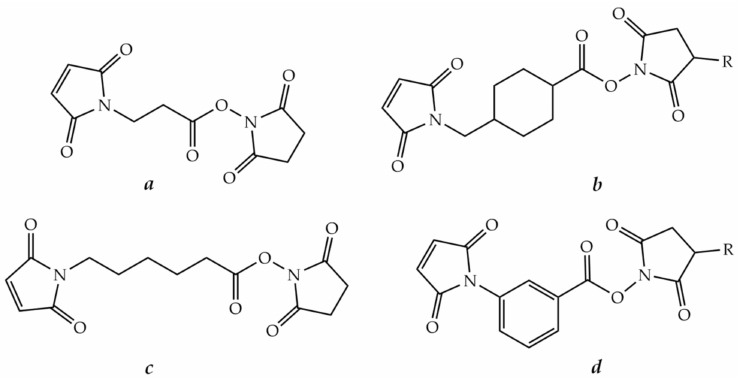
Figure 10. Reagents for the introduction of the malemide group: activated N -succinimidyl esters of β -maleimidopropionic ( a ), 4-maleimidomethylcyclohexanecarboxylic ( b ), ε -maleimidohexanoic ( c ), and 3-maleimidobenzoic ( d ) acids; R = H or SO 3